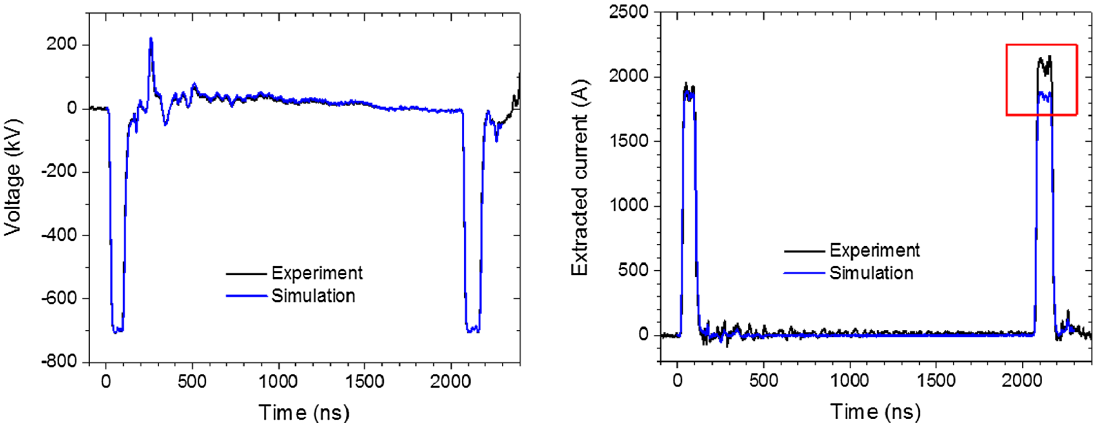
FIG. 4. Left: diode voltage V used in the simulation (blue curve) and measured experimentally (black curve) for a delay of 2 μ s in between the two pulses. Right: extracted current measured experimentally (in black) and simulated (in blue) for a delay of 2 μ